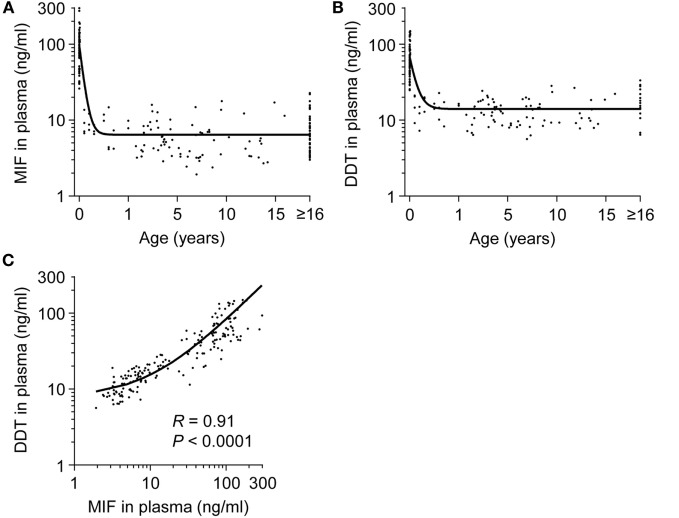
Plasma concentrations of macrophage migration inhibitory factor (MIF) and d-dopachrome tautomerase (DDT) in healthy subjects from birth to adulthood. MIF (A) and DDT (B) plasma concentrations in the umbilical vein of 60 healthy term newborns and in the peripheral blood of 12 healthy term newborns, 17 infants, 73 children, and 58 adults (19 adults for DDT). The regression lines are shown. (C) Scatterplot comparing MIF to DDT concentrations in paired measurements from all age groups. The regression line is shown. Data from (A) was obtained from Ref. (33).